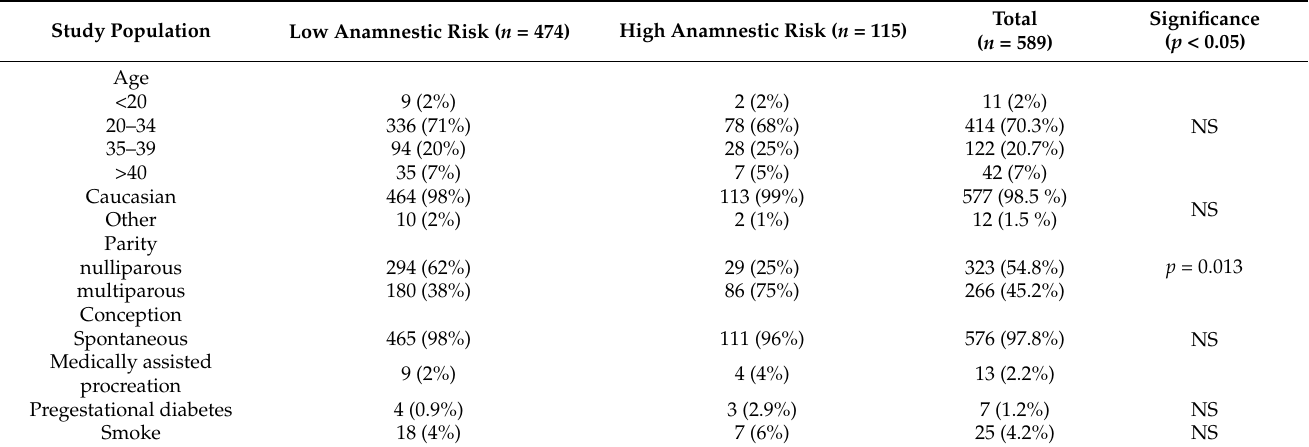
Table 1. Characteristics of the study population.